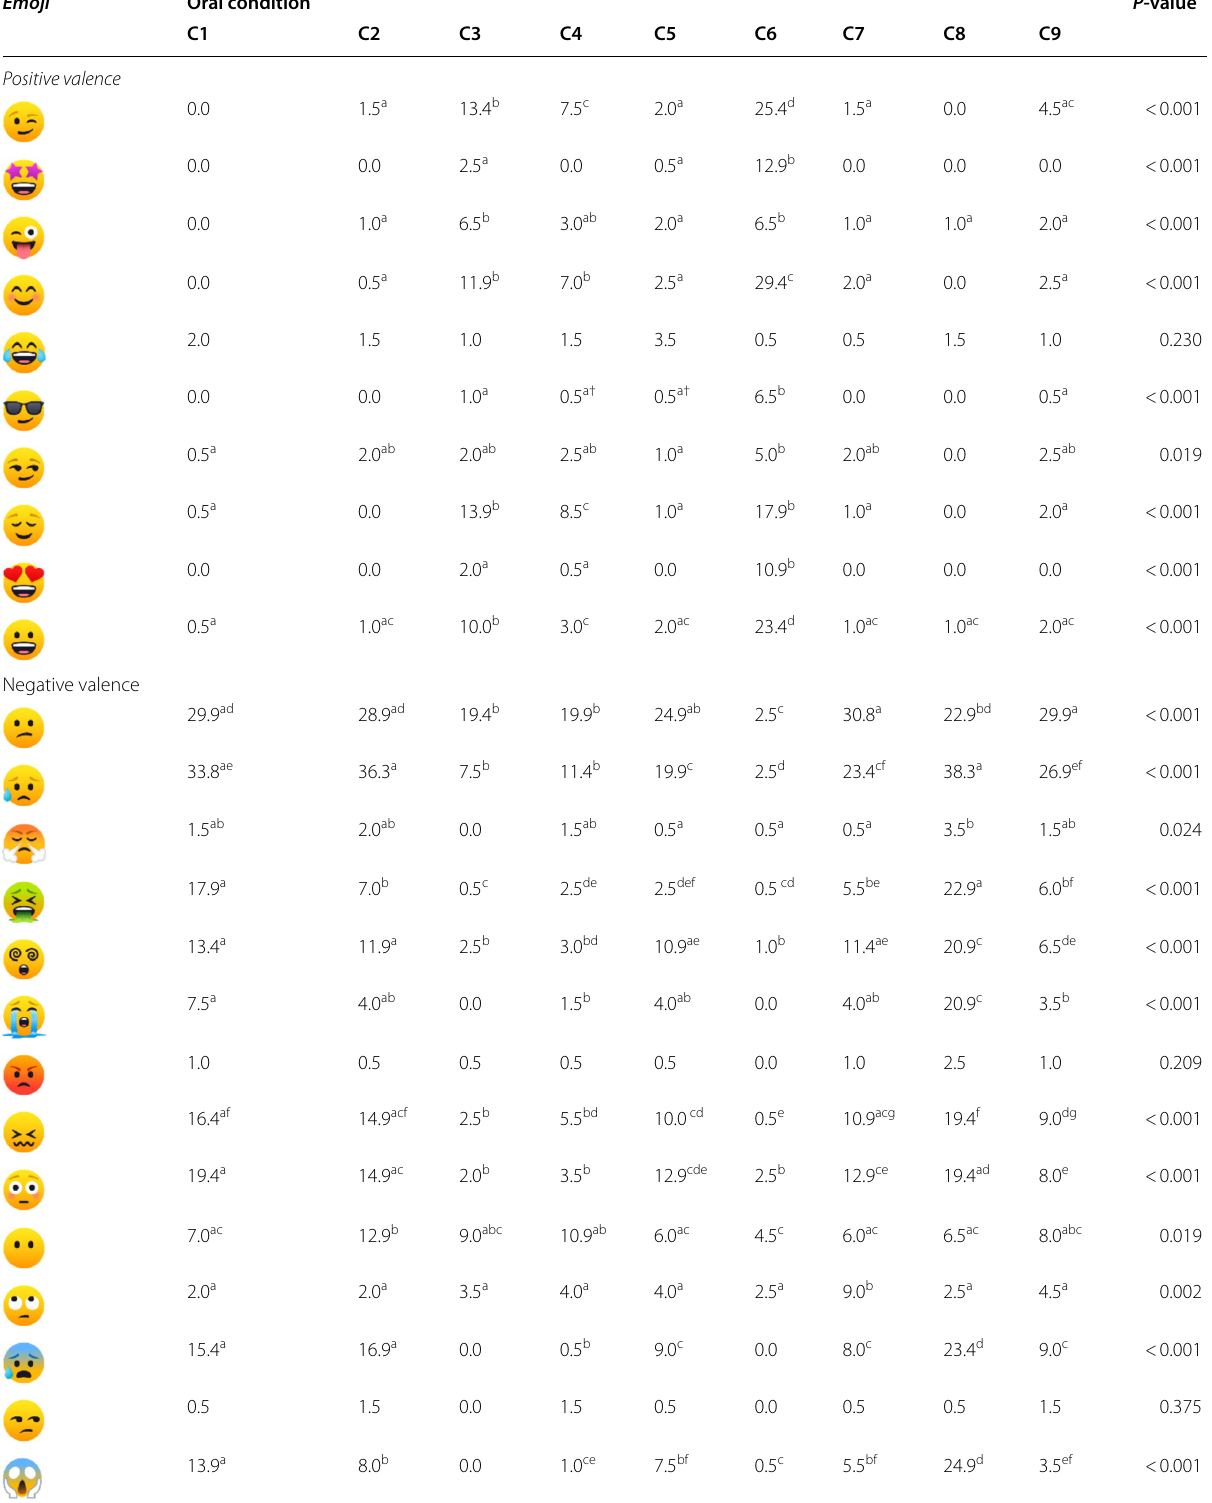
Table 2 Frequency (%) of choice of each emoji among the oral conditions Emoji Oral condition Positive valence